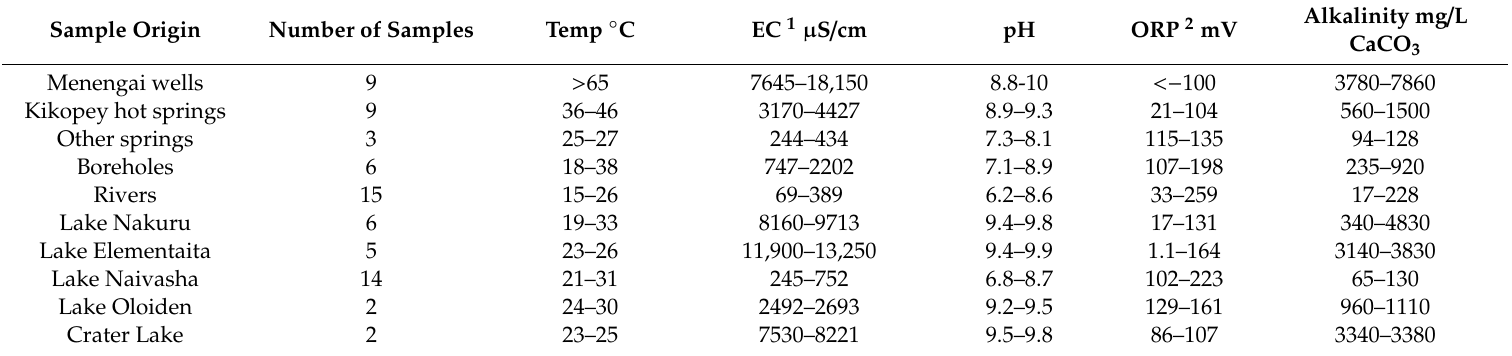
Table 2. Summary of measured field determinations along the studied section of the Kenyan Great Rift Valley.